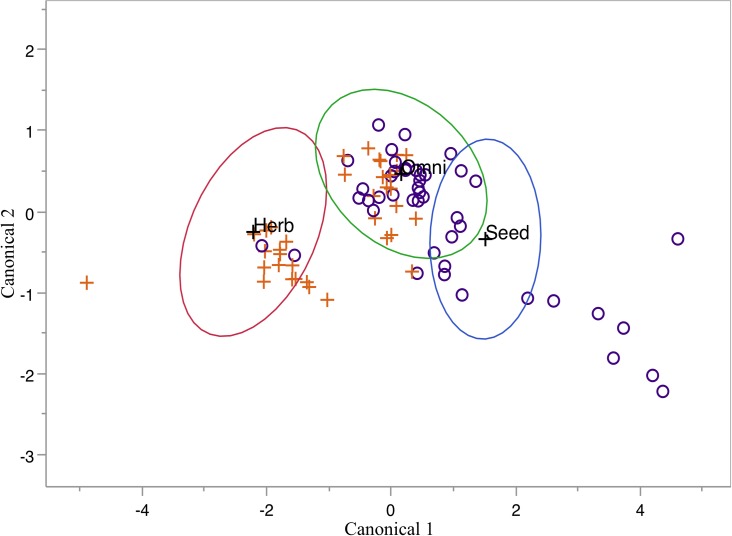
Fossils analysis.Samples from Sterkfontein Member 4 (purple circles) and Swartkrans Member 1 (orange crosses) were treated as unknowns in our dietary model. Ellipses represent 50% of the distribution of the training specimens where blue = seed eater; green = omnivore; red = herbivore.